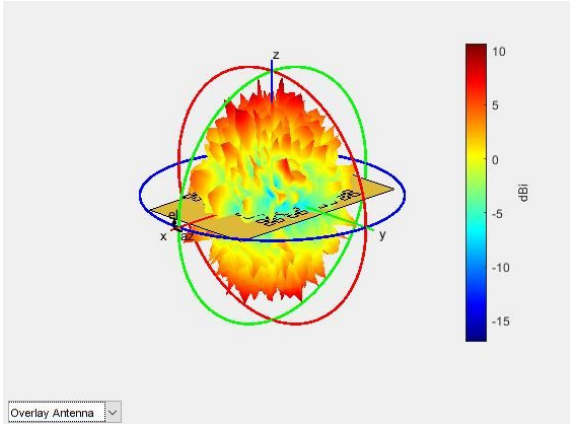
Figure 13. Fractal antenna pattern radiation overlay.